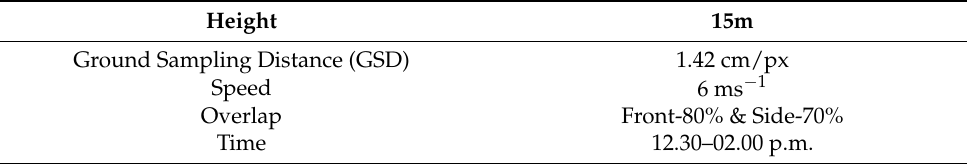
Table 4. UAV Flight Mission.